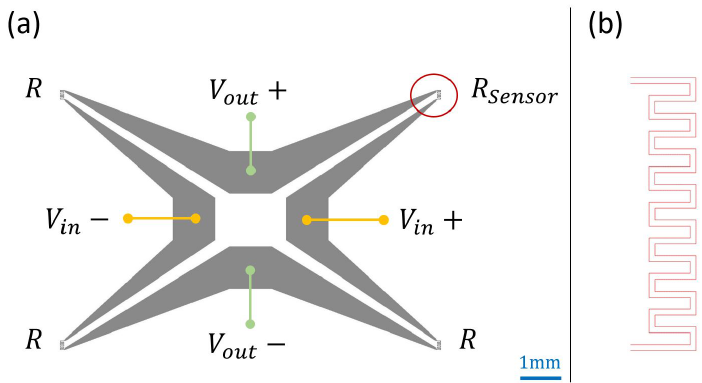
Figure 16. ( a ) Sensor design revision 1.0 with Wheatstone bridge ( b ) Sensing element